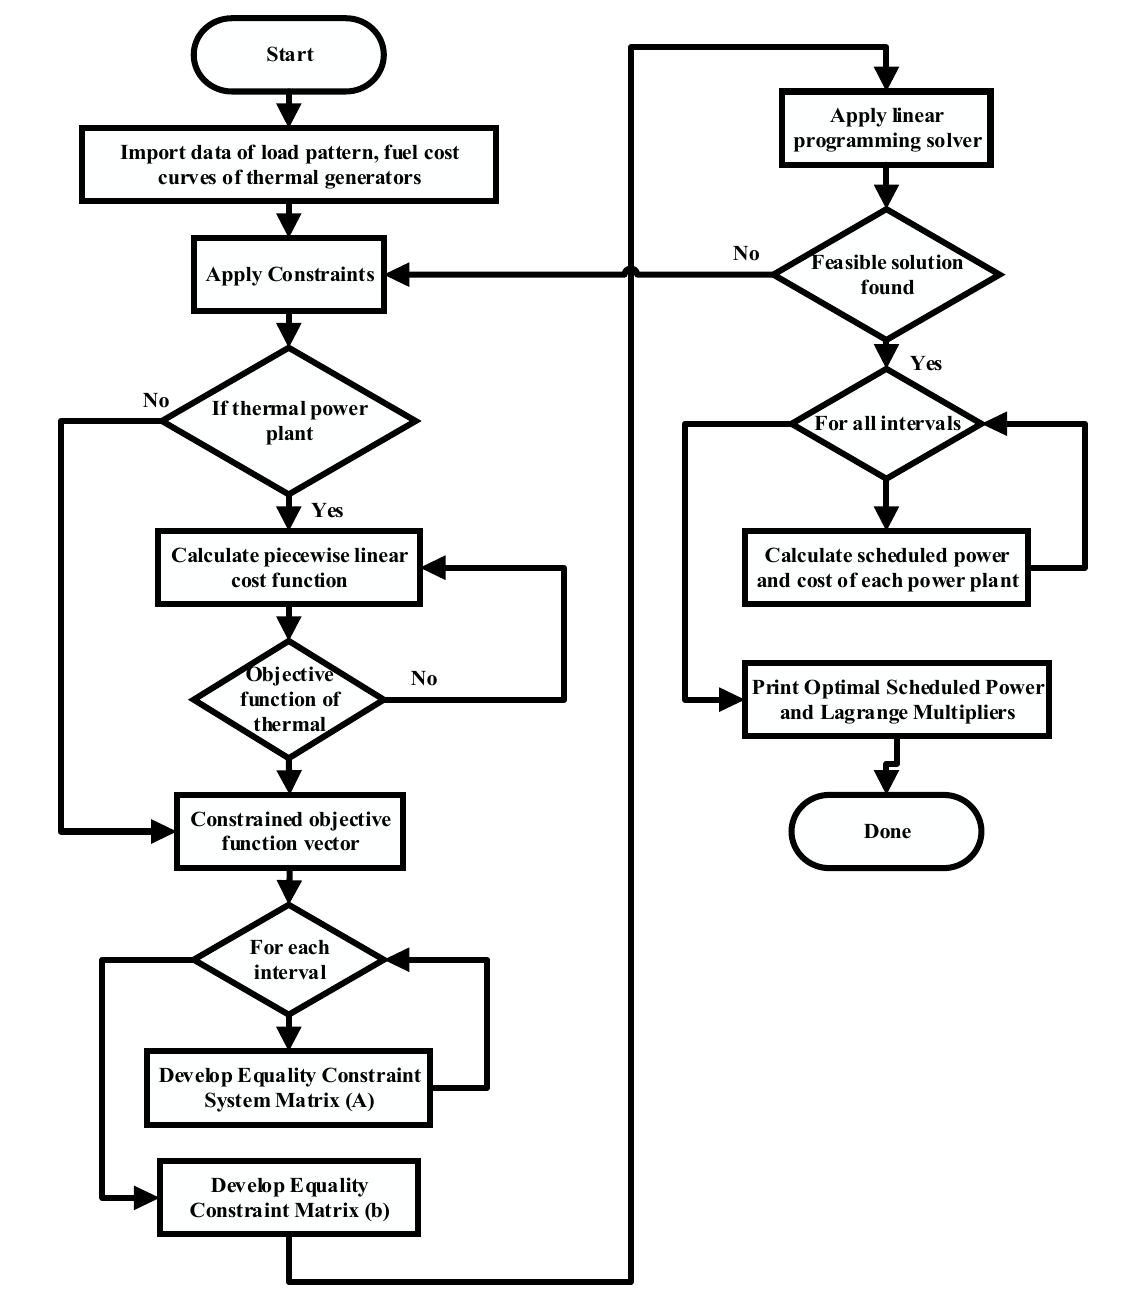
Figure 3. Algorithm fl ow chart.